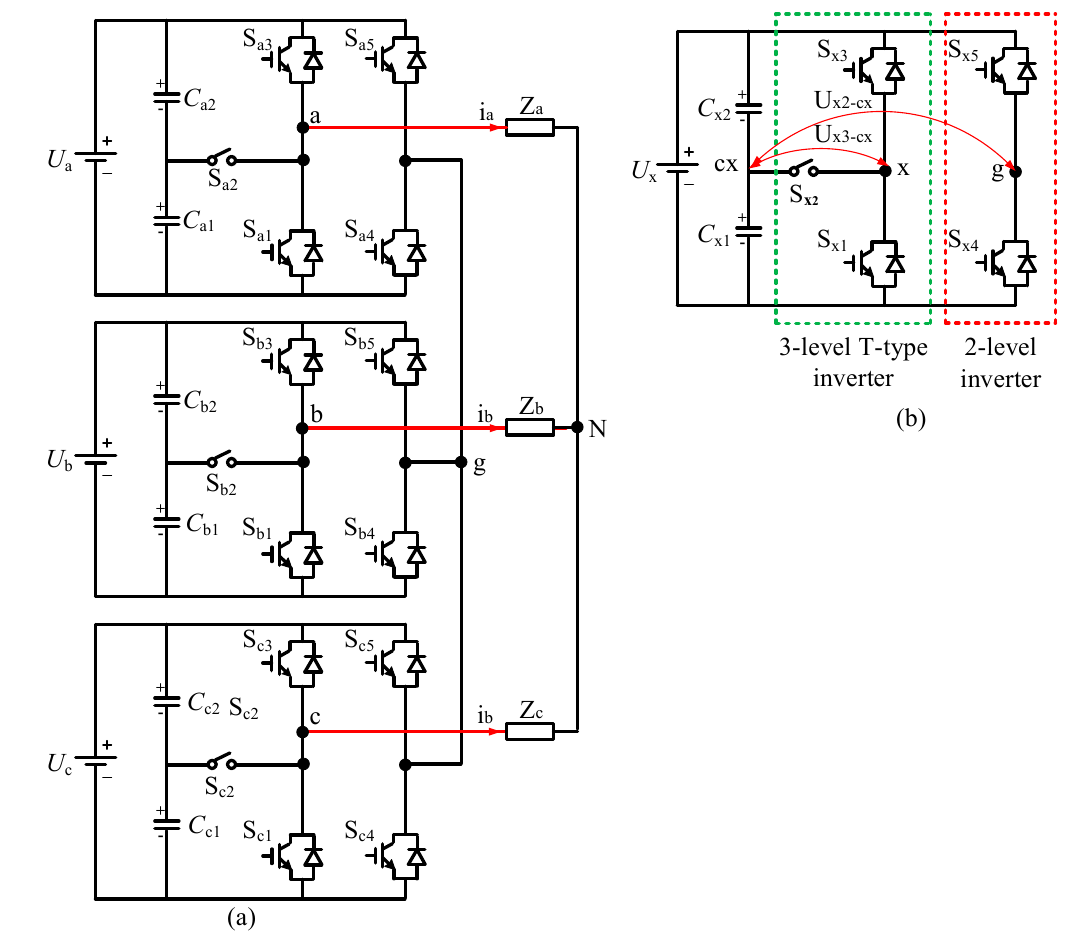
Figure 1. Five-level T-type H-bridge inverter topologies. ( a ) Three-phase inverter and ( b ) One phase module.